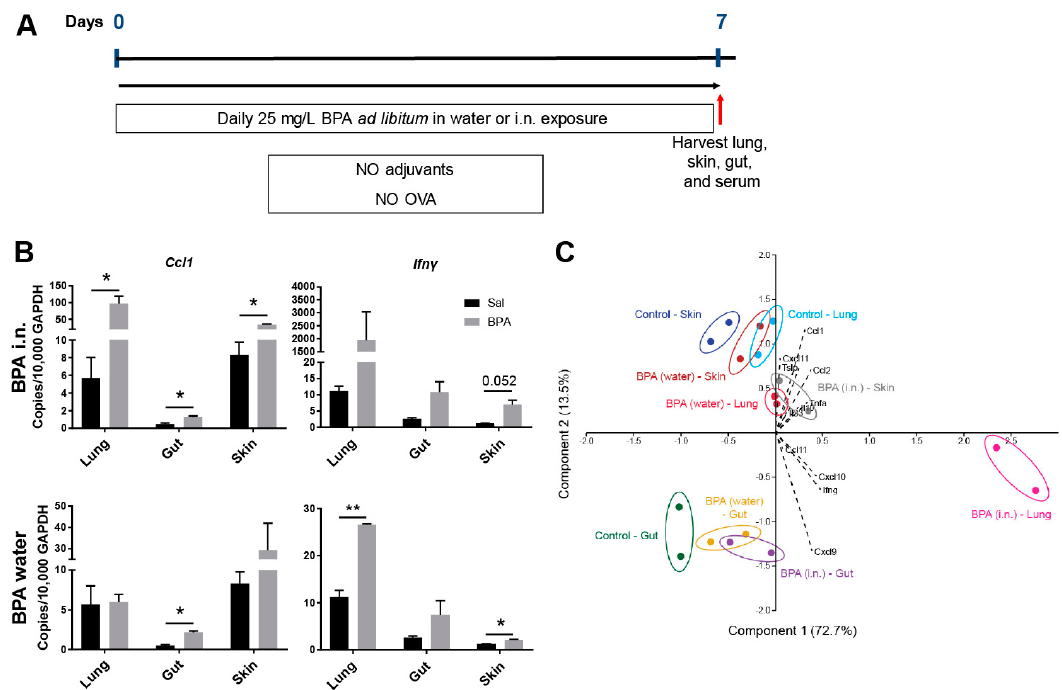
Figure 2. Ingestion of BPA promotes systemic para-inflammation in mice. ( A) BPA administration protocol. (B) Expression of Ccl1 and Ifng in murine lung, gut, and airway after seven days of BPA exposure. Top graphs, exposure by intranasal inhalation; bottom graphs, exposure through ad libitum water intake. N = 2 mice/group/9 groups, all data are from one experiment. *, p < 0.05, **, p < 0.01 by t-test within each tissue compartment. ( C) Exploratory PCA analysis of log10-normalized values of gene expression measured at all tissue sites (lung, skin, gut) following BPA exposure via water intake or by inhalation (see Methods for list of genes/groups).